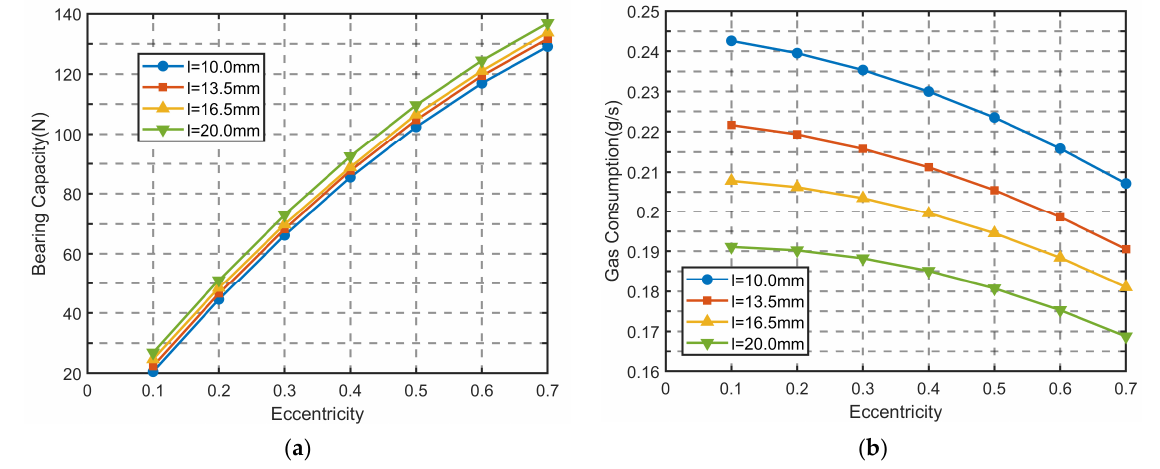
Figure 7. Influence of orifice position on ( a ) bearing capacity and ( b ) gas consumption.